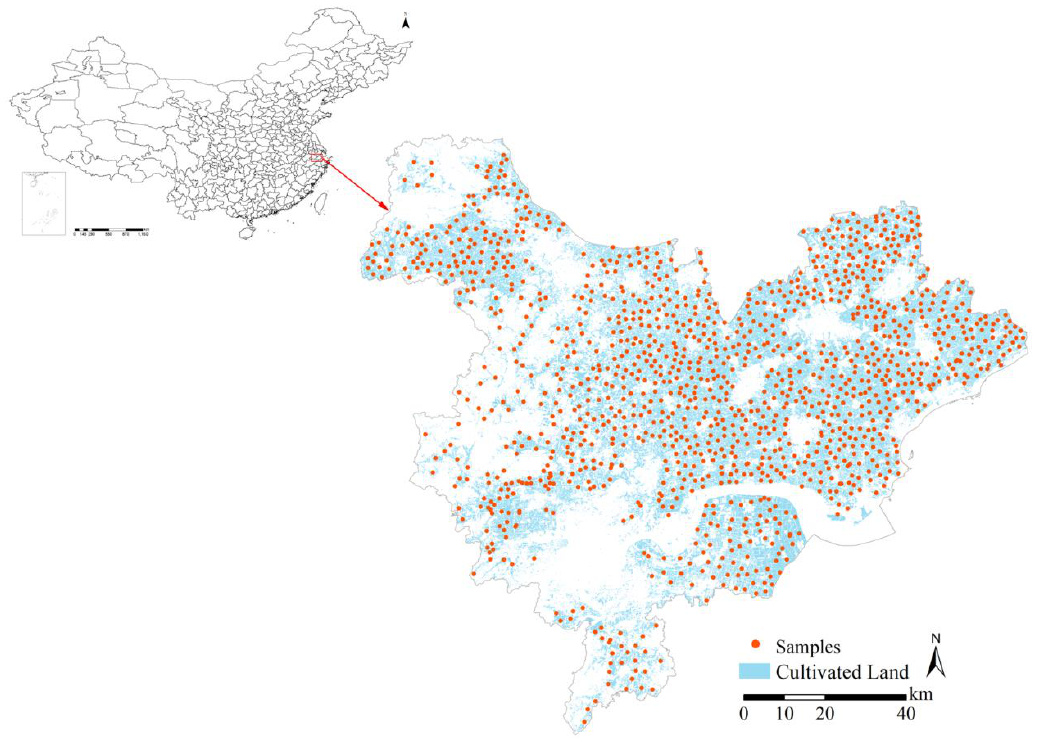
Figure 1. The location of the study area and distribution of samples across the cultivated land area.